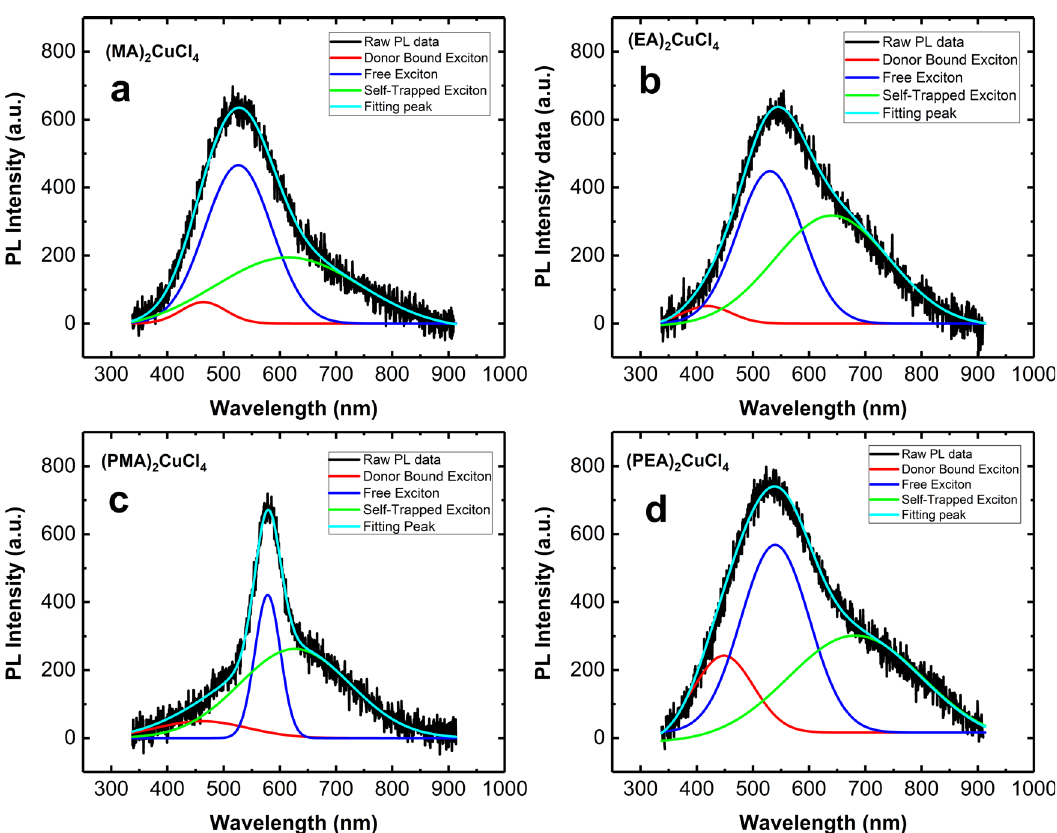
Fig. 4 Room-temperature photoluminescence of A 2 CuCl 4 compounds. PL spectra and the deconvoluted excitonic signatures of (MA) 2 CuCl 4 ( a ), (EA) 2 CuCl 4 ( b ), (PMA) 2 CuCl 4 ( c ), and (PEA) 2 CuCl 4 ( d ), respectively. Raw PL data (black), donor bound exciton (red), free exciton (blue), self-trapped exciton (green), and fi tting peak (cyan). Error bars are collected from the respective fi tting (Fig. 3c, d) Cu-perovskites share comparable fi ndings. It is